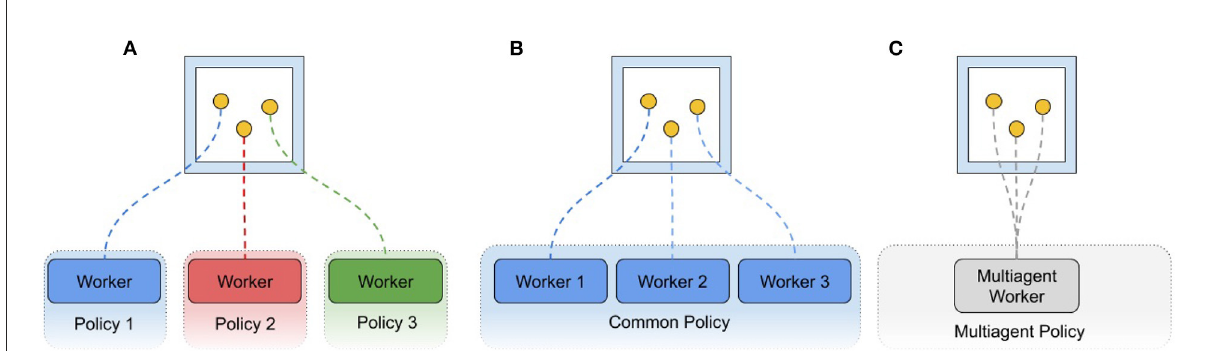
FIGURE2 Possible worker configurations. Policy workers may be attached in environment entities in any desired combination. (A) Three entities are assigned to three independent policies that are learning separately and may have workers attached to other environments. (B) Entities are each attached to workers of the same policy, such that some of the agents contributing to the policy are coexisting in the same environment. (C) Entities are all attached to the same policy worker, which takes all of their data into account in a multiagent manner, possibly one of many workers for a distributed multiagent algorithm.